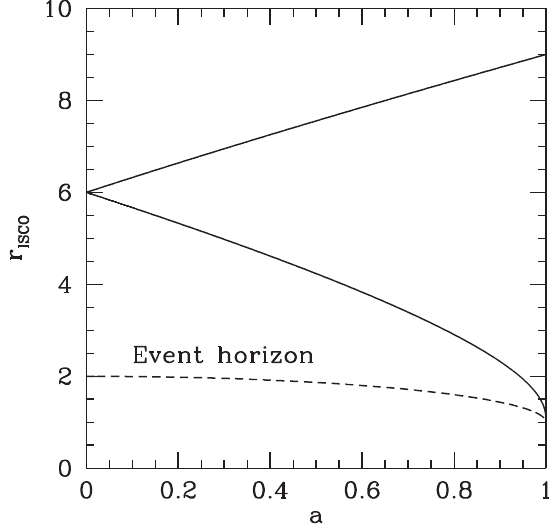
Figure 2. The radius of the Innermost Circular Orbit as a function of the adimensional angular momentum of the black hole, a (solid curves). The lower curve refer to matter corotating with the black hole, the upper curve to counter-rotating matter. The radius of the event horizon is also shown (dashed